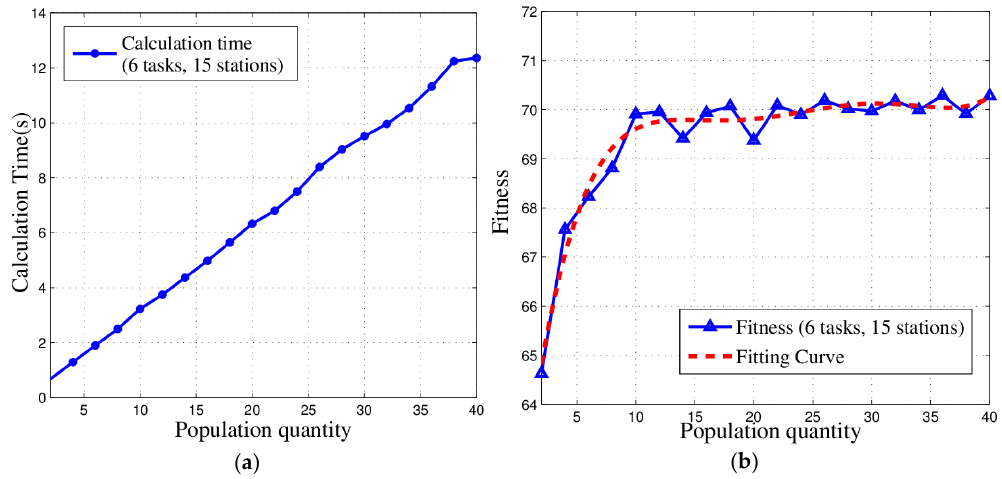
Figure 12. Relationships among time complexity, fitness and population: ( a ) Time complexity- population curve; ( b ) Fitness-population curve.